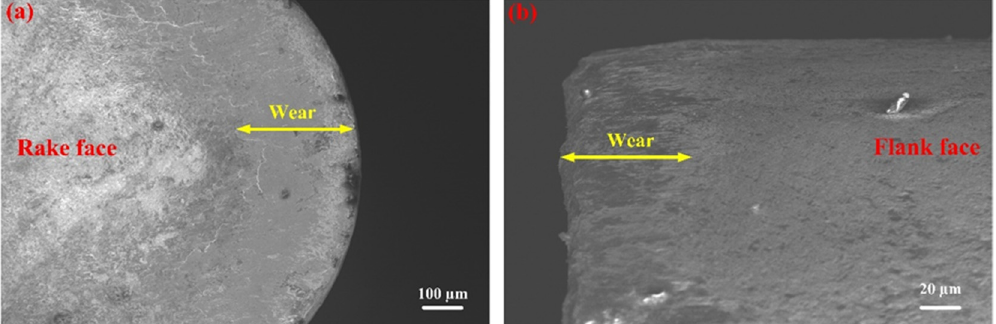
Figure 7. Tool wear after machining of the RZ5/8 wt.% TiB 2 composite, with ( a ) the rake face and ( b ) the flank face indicated